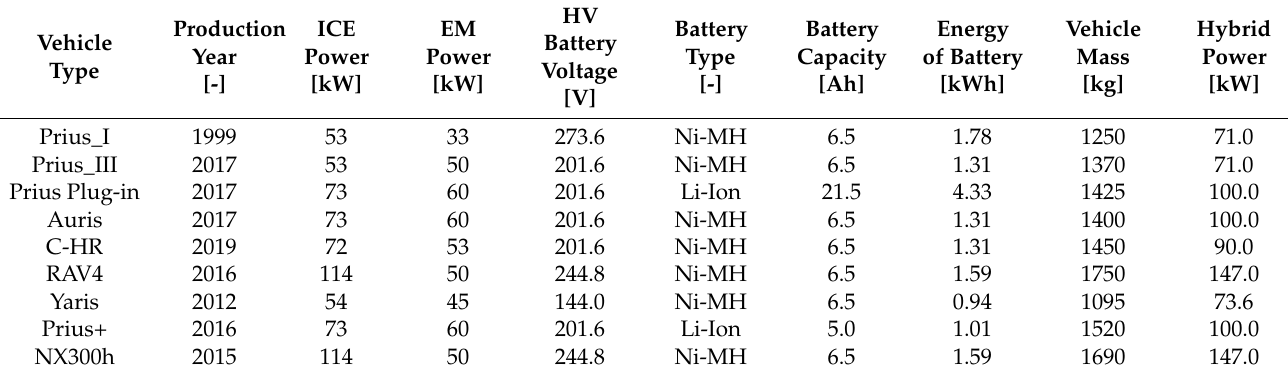
Table 1. Technical data of tested hybrid vehicles [35 – 38].